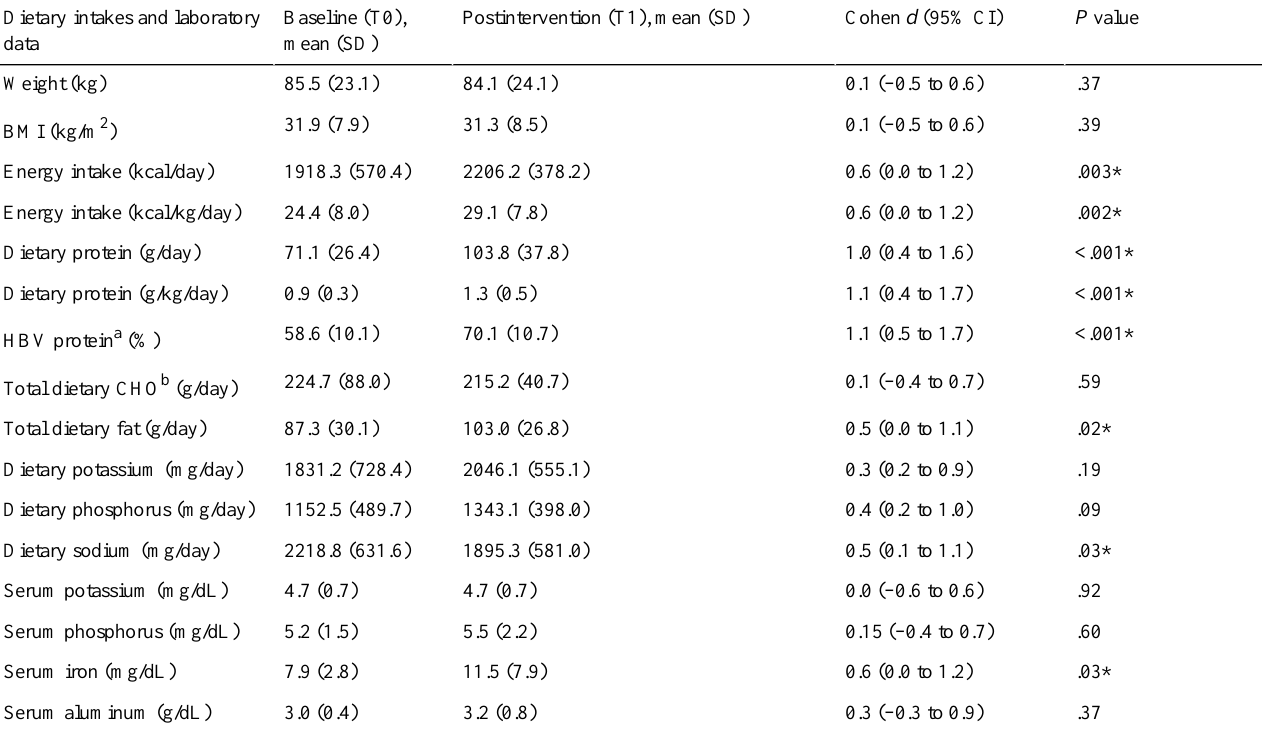
Table 2. Dietary intakes and laboratory data at baseline and postintervention.